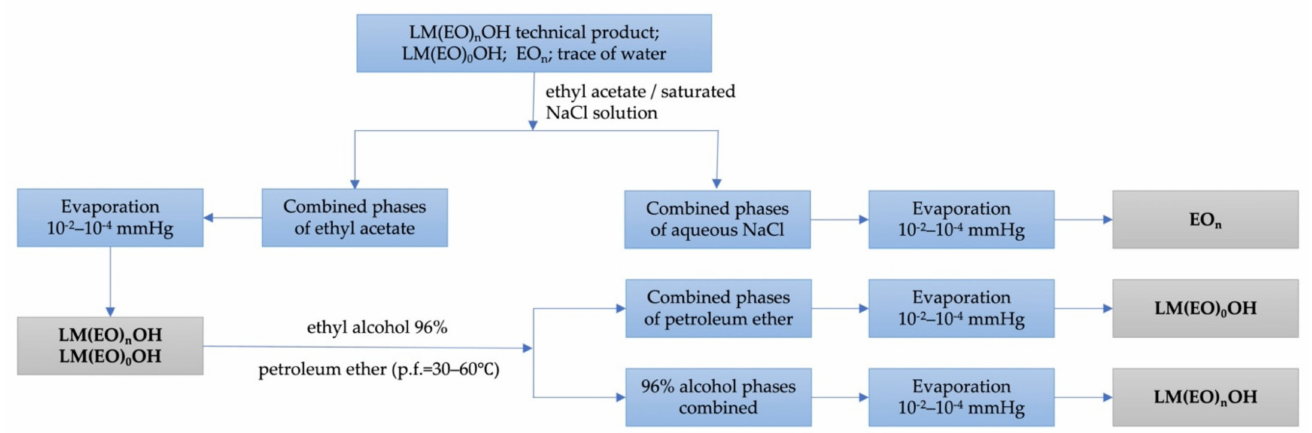
Figure 3. The block scheme of operations for the purification of LM(EO) n OH technical product from traces of water, LM(EO) 0 OH, and EO n by repeated solid/liquid and liquid/liquid